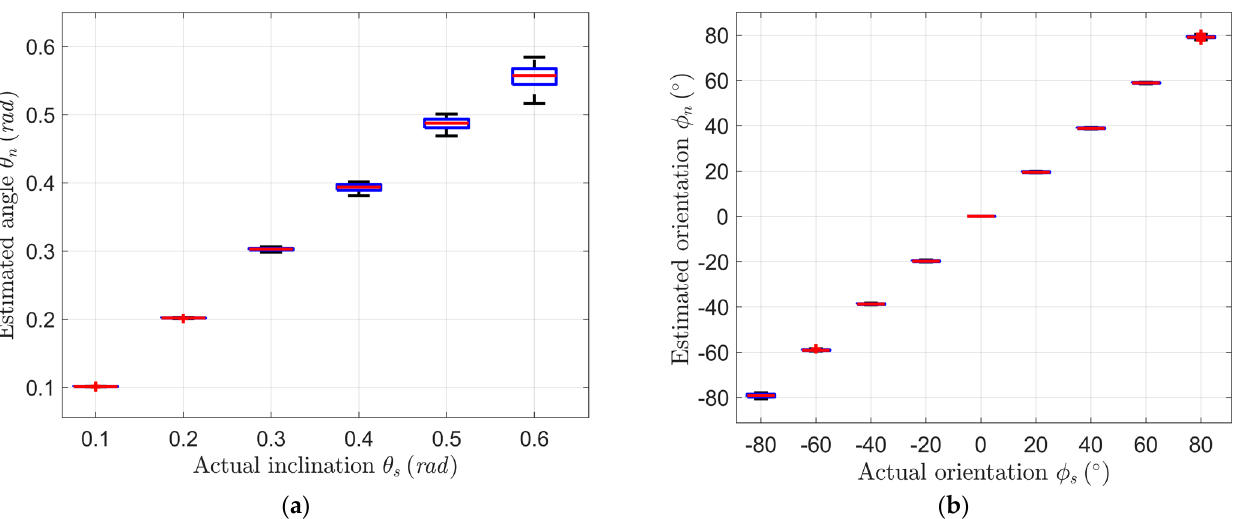
Figure 10. Estimation of different slopes. ( a ) The estimation of slope inclination; ( b ) The estimation of slope orientation.